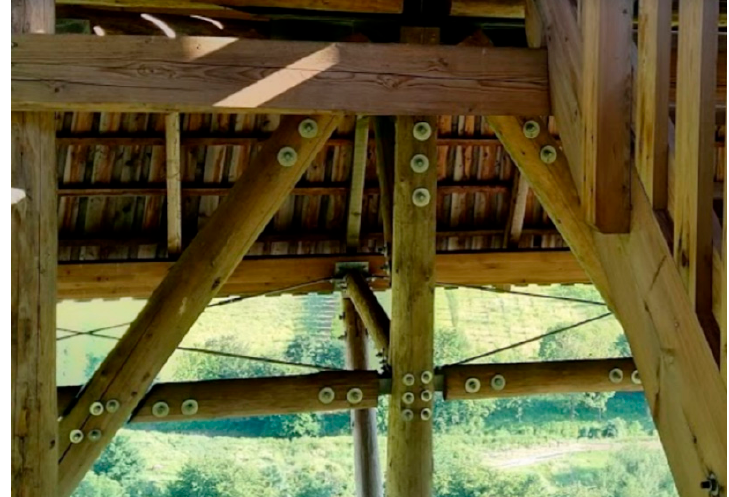
Figure 1. Practical use of connections in timber structures with mechanical fasteners and steel plates.